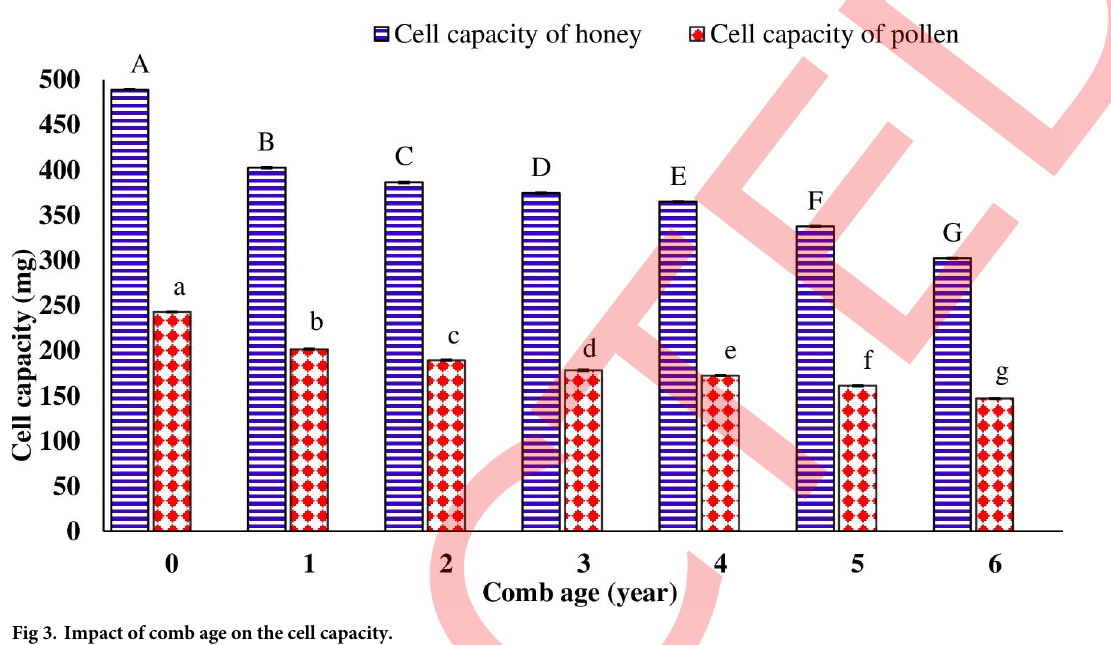
Fig 3. Impact of comb age on the cell capacity.